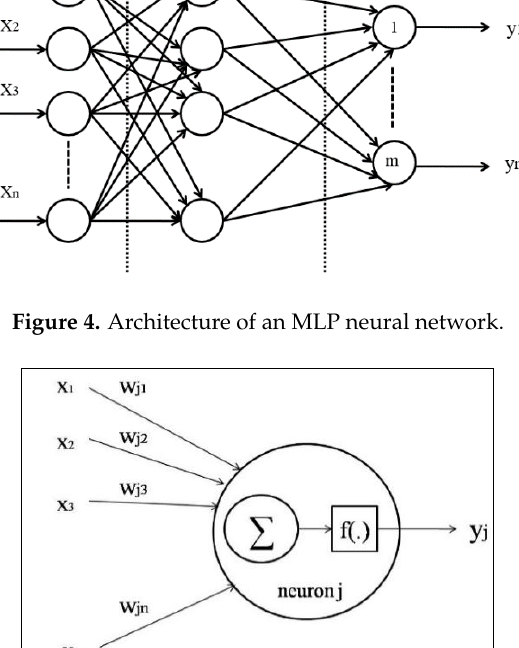
Figure 5. A node of MLP: an artificial neuron.